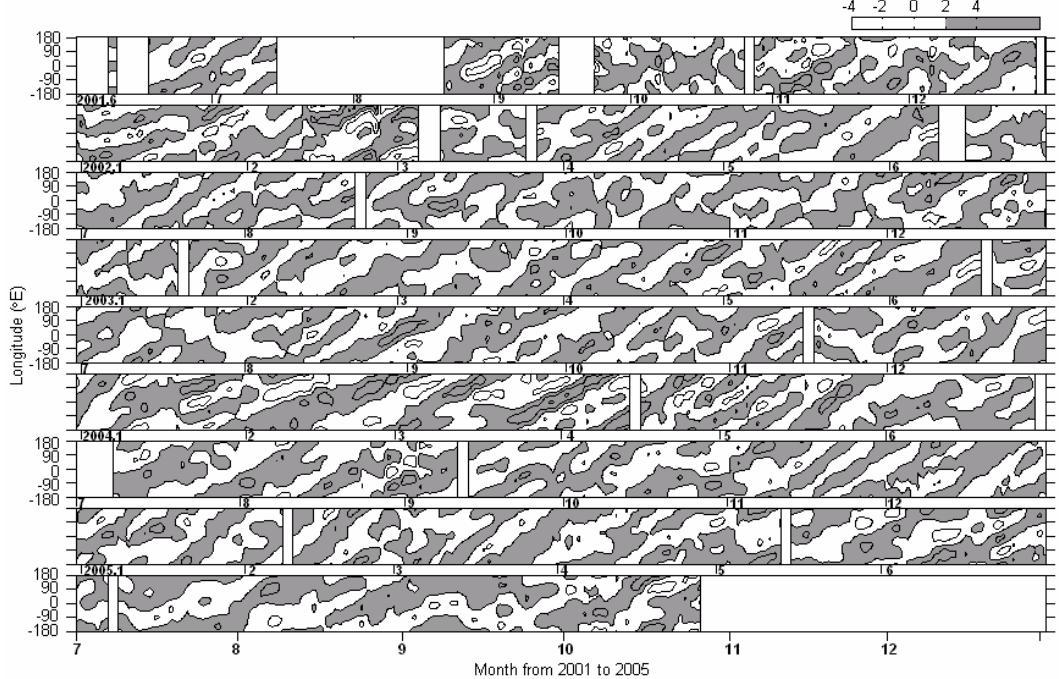
Figure 3. Time-longitude sections of fitted Ts’ contours at 20 km altitude constructed from wave 1 and wave 2 components between June 2001 and October 2005. The month number starts from the first of each month and the vertical blank periods indicate the missing data. The positive and negative perturbations are shown in gray and white color, respectively. Note that this is the extension figure of Tsai et al. (2004).